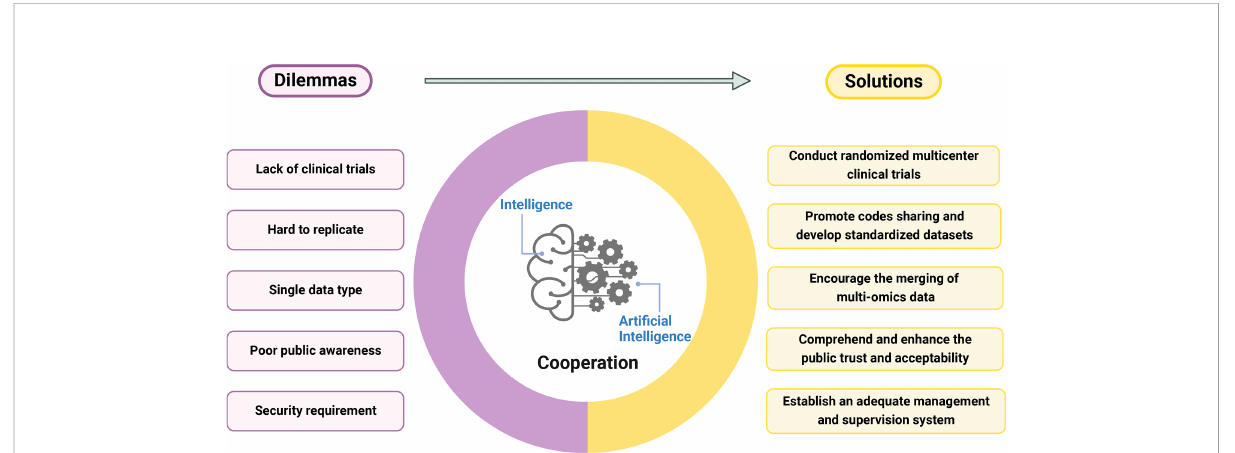
FIGURE 3 The dilemmas and solutions in predicting immunotherapy ef fi cacy with AI. The left side outline the current dif fi culties AI encountered, and the right side proposes possible solutions. And only the excellent cooperation of arti fi cial intelligence and human intelligence can achieve the best prediction